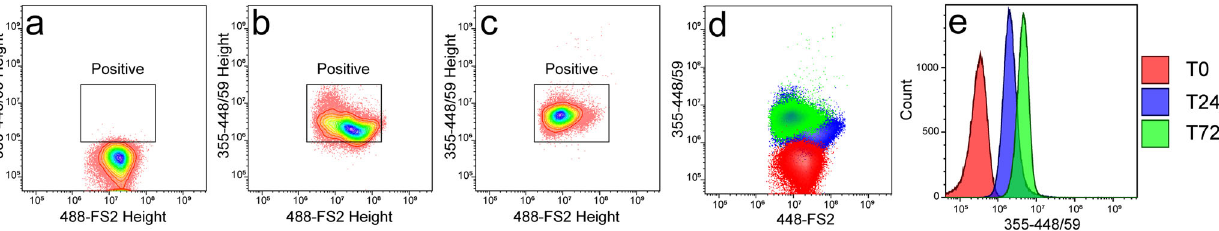
Fig. 4 Flow cytometry of B. cellulosilyticus grown on AcGGM. a – d Gating strategy developed based on 355 nm Height (2-AB) vs. 488-FSC2 Height (DNA- dye), clearly observed shifts based in fl uorescence of bacteria grown on unlabelled glycans a T0, compared to bacteria grown on labelled substrates for T 24 b or T 72 h c . d The overlapped dot-plot demonstrates the incorporation over time by increasing levels of fl uorescence (labelled cells. B. cellulosilyticus grown on AcGGM) at 24 h (blue) and 72 h (green) compared to the unlabelled substrate (red). e Histogram indicating the shift in fl uorescence observed for cells grown on labelled substrates for 24 h (blue) and 72 h (green) compared to the unlabelled substrate